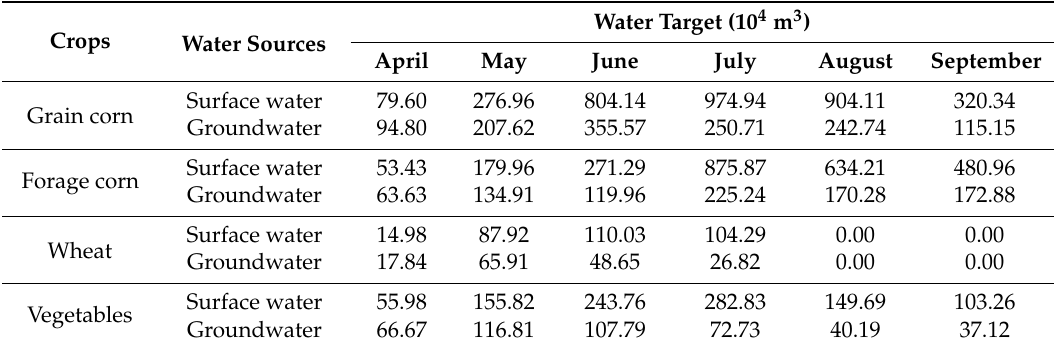
Table 3. Water targets.